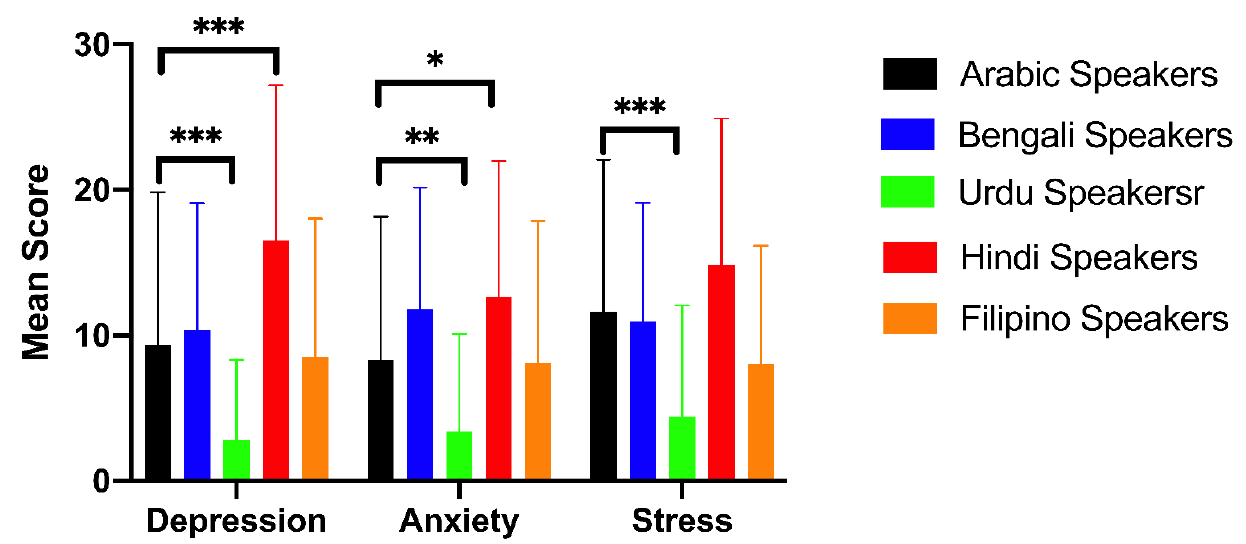
Figure 1. Average DASS-21 subscale scores by language speakers. * p < 0.05, ** p < 0.01, *** p < 0.001.